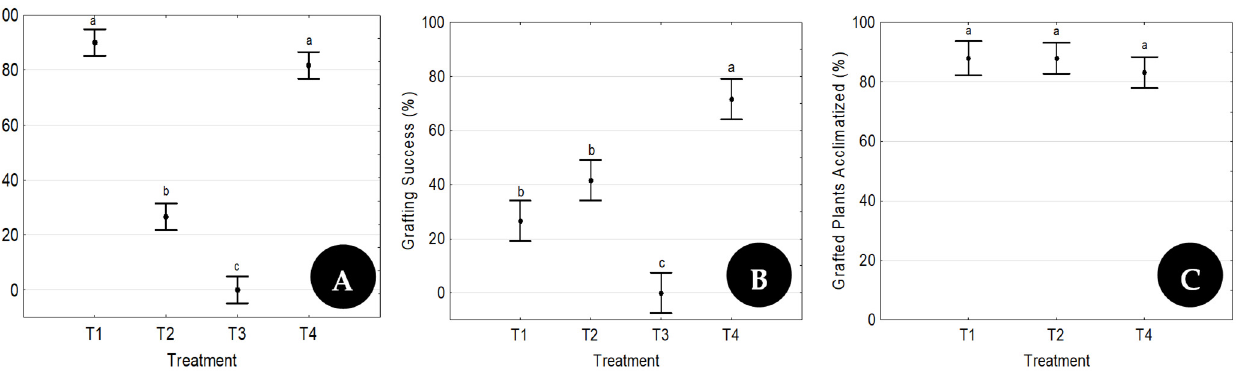
Figure 6. Rootstock rooting ( A ), grafting success ( B ), and number of acclimatized grafted plants ( C ). High–low bars represent the confidence intervals (LSD 95%), and different letters refer to statistically significant differences among treatments for each parameter under evaluation ( p ≤ 0.05).